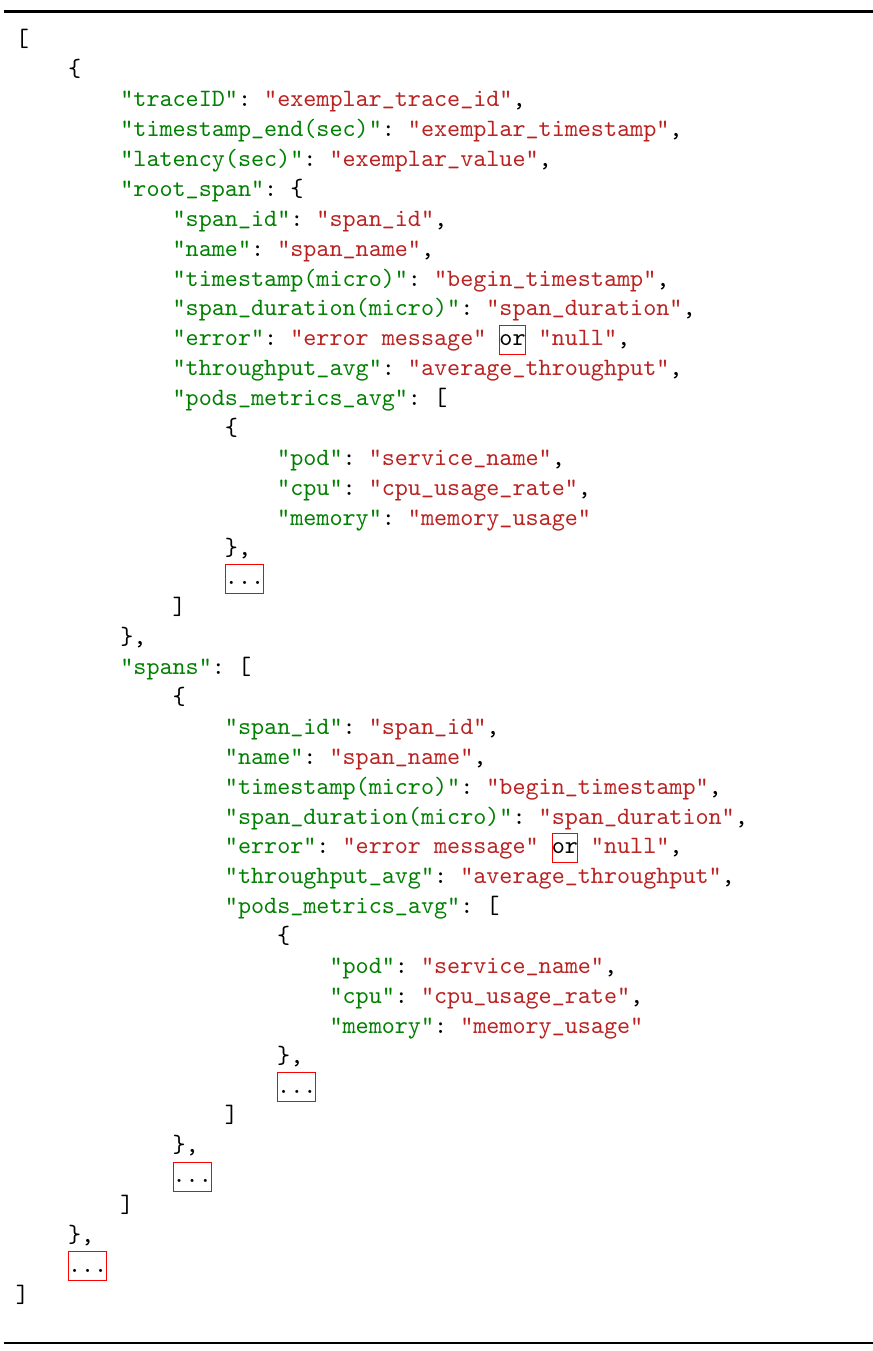
Listing 1. JSON data fusion schema in Kubernetes orchestration